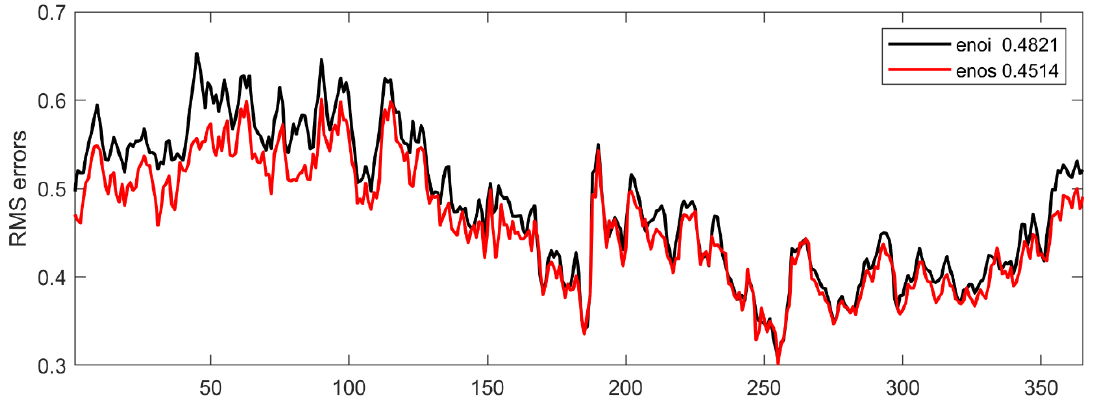
Figure 11. RMSE of the target and analysis fields for the entire year obtained via spatial averaging of the twin trials for 365 days in 2015. Black line: results of EnOI. Red line: results of EnOS.